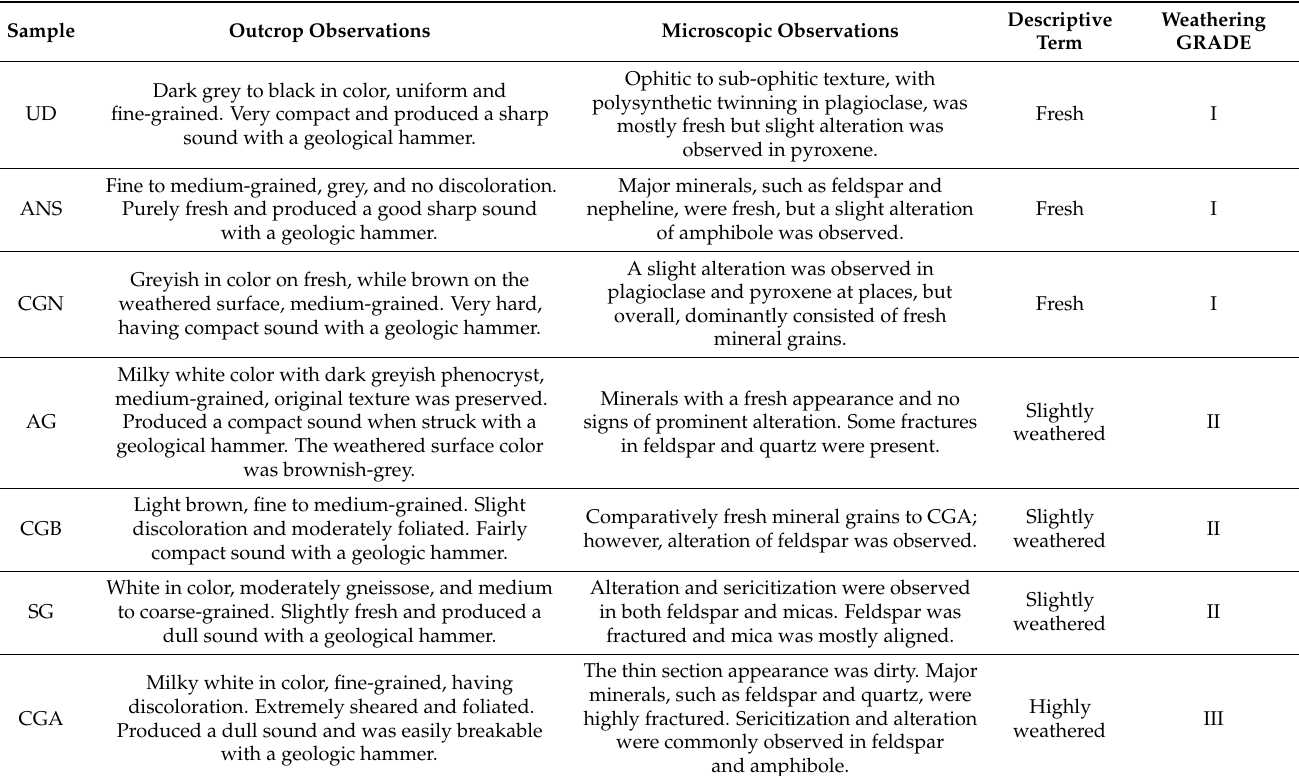
Table 3. Weathering classification of the investigated rocks (after Irfan and Dearman [37] and Borrelli, Greco, and Gull à